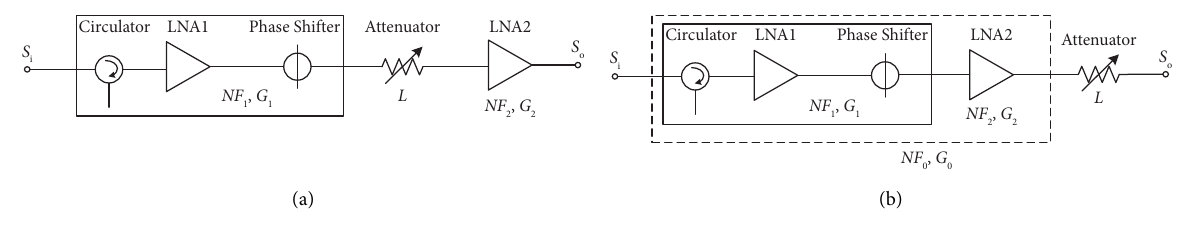
Figure 7: Block diagram of T/R